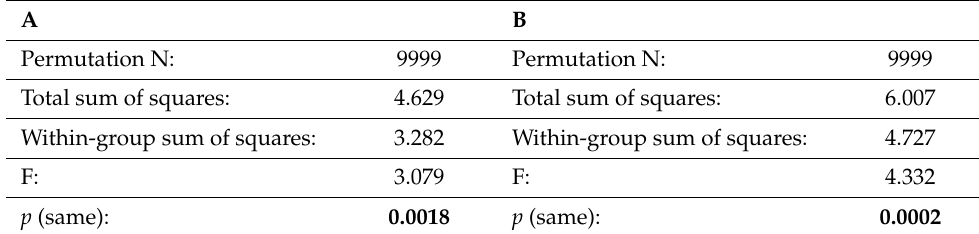
Figure 2. Two-way Hierarchical Cluster Analysis (HCA) of the spontaneous emission of the plants belonging to the Mentheae tribe. Table 1. Effects of Subtribes ( A ) and Tribes ( B ) on the Volatile Organic Compounds (VOCs) according one-way PERMANOVA